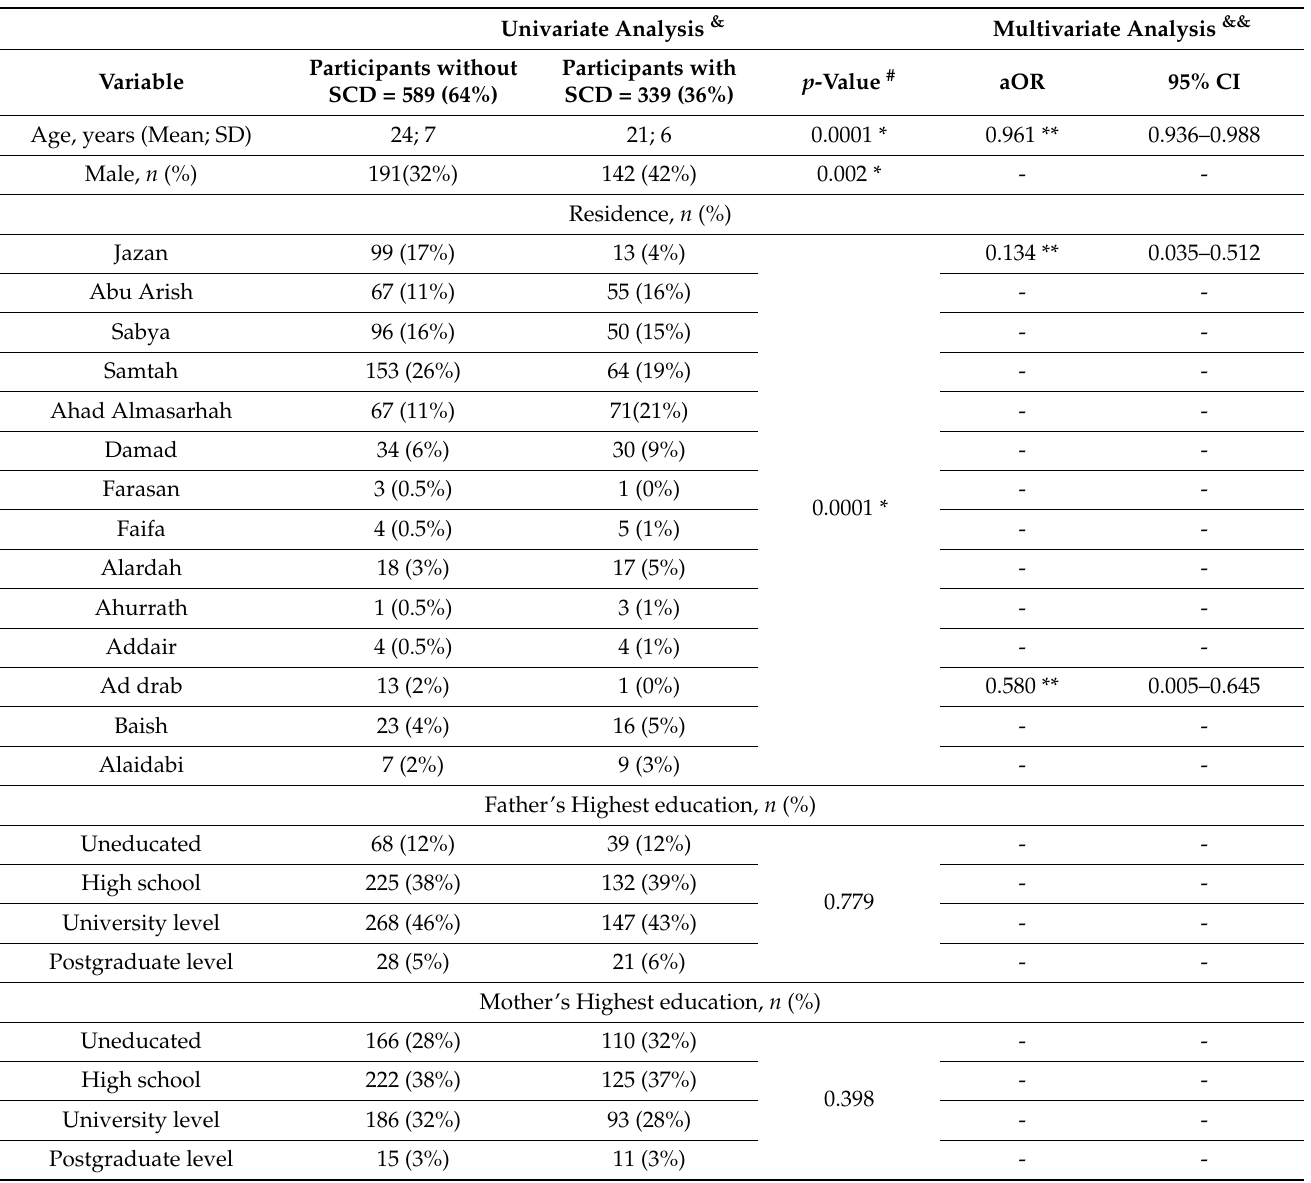
Table 2. Comparison between healthy participants and participants with